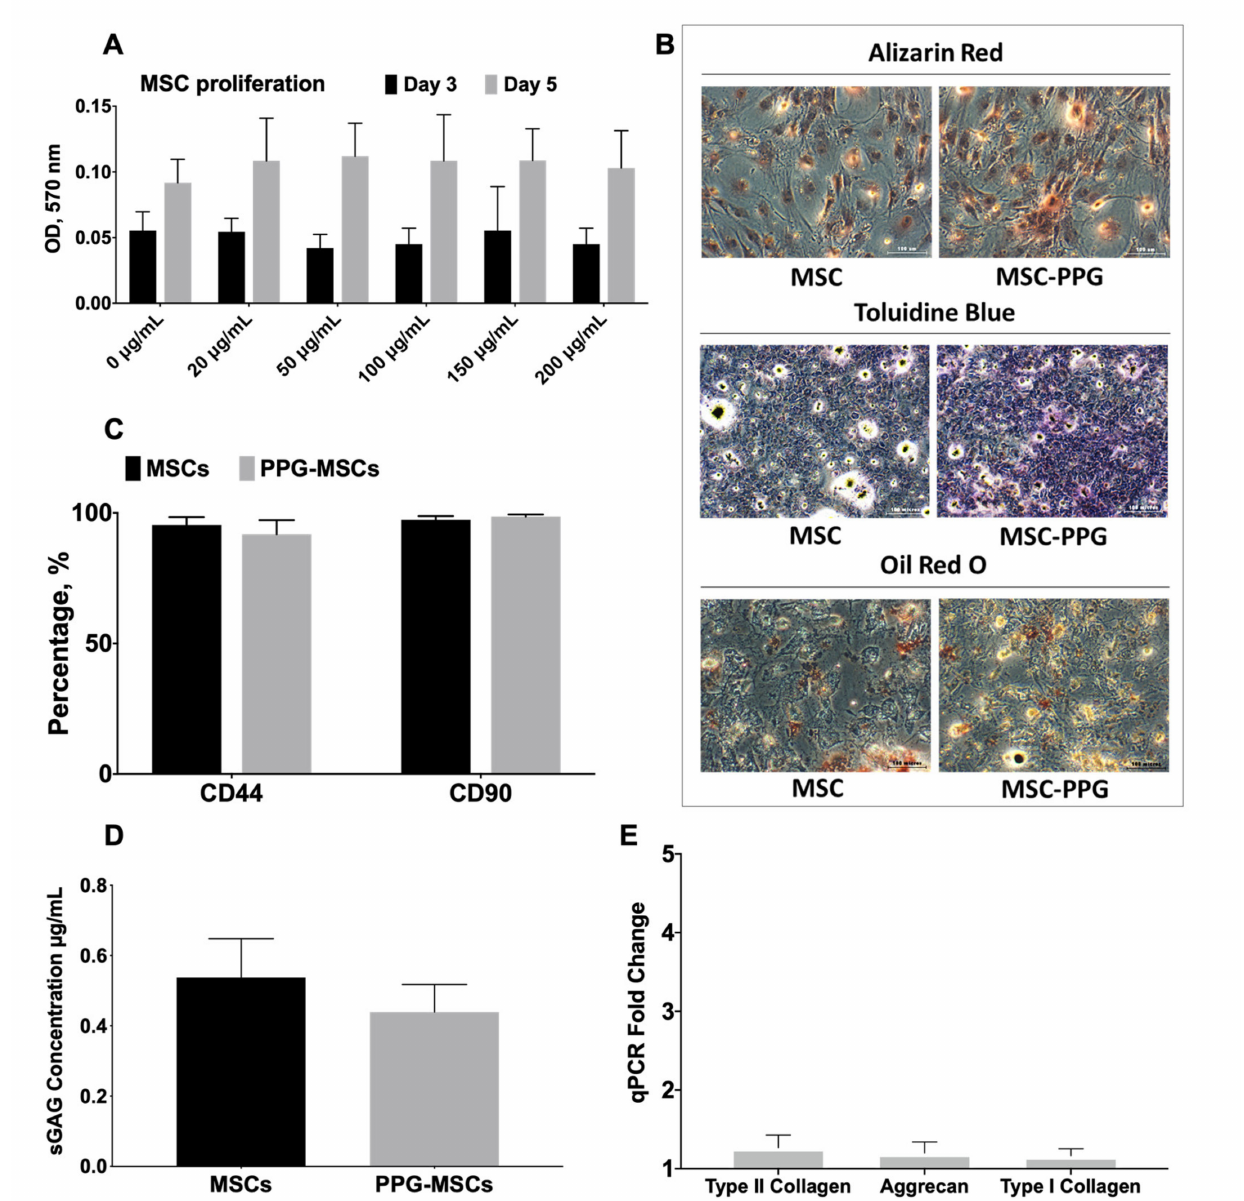
Figure 3. The effect of PPG coating on MSCs’ proliferation and differentiation in monolayer culture. ( A ) Bar graph showing the effect of PPG on MSCs proliferation in monolayer culture ( B ) The effect of PPG on multilineage differentiation with Alizarin red for osteocytes, Toluidine blue stain for chondrocytes and Oil Red O stain for adipocytes. ( C ) Bar graph showing the stemness marker CD44 and CD90 between MSCs and PPG-MSCs in the monolayer culture. ( D ) The effect of PPG on sGAG production in the monolayer culture. ( E ) The chondrogenic gene expression (fold change) of PPG-MSCs relative to the MSCs (control